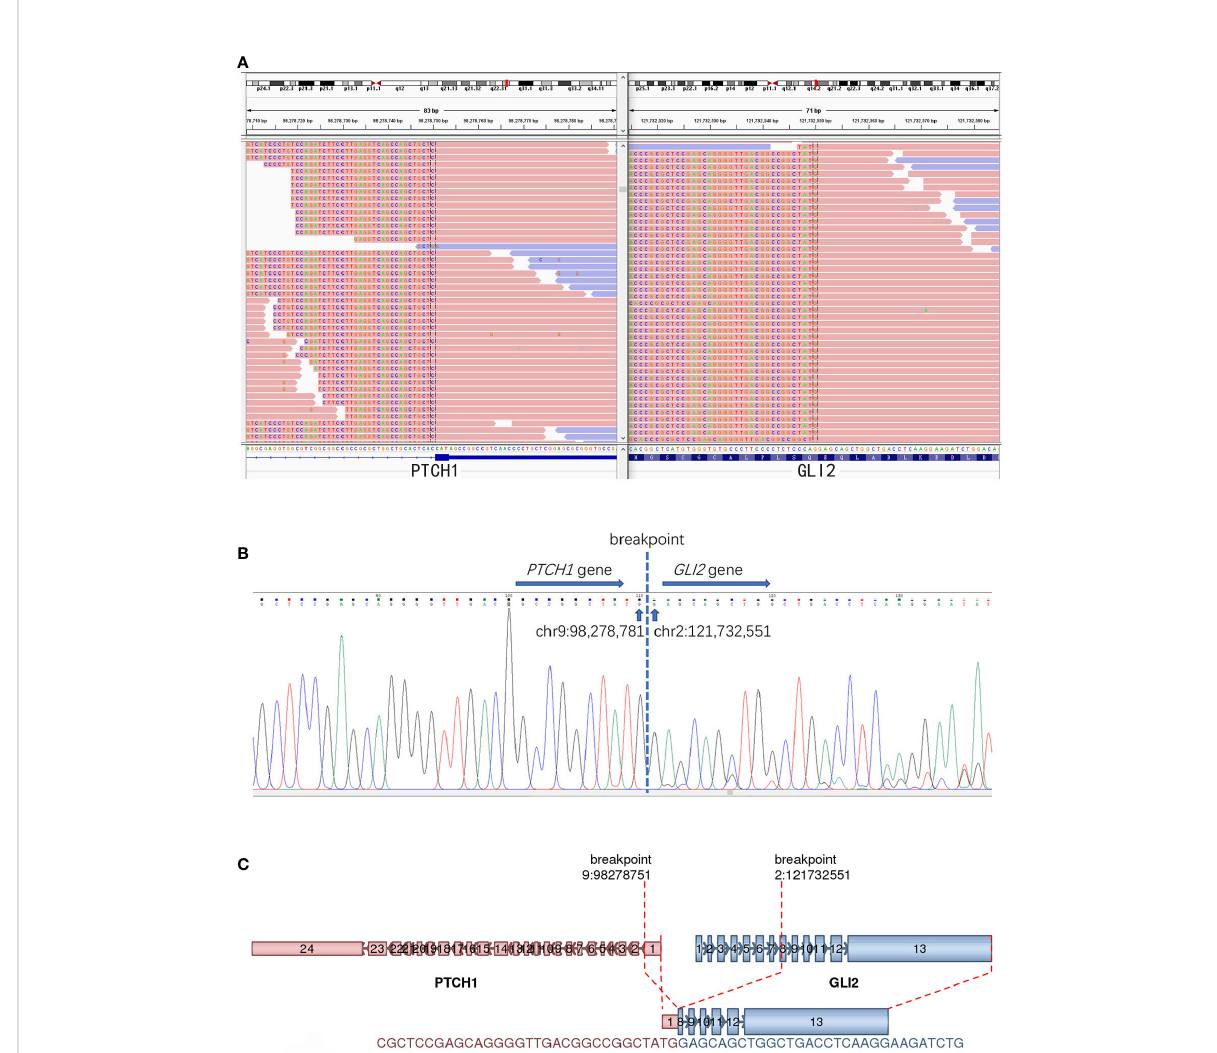
FIGURE 3 The detection of PTCH1::GLI2 fusion. (A) RNA-based NGS revealed a novel PTCH1::GLI2 fusion. (B) PTCH1::GLI2 fusion were con fi rmed by Sanger sequencing. (C) Schematic representation indicates PTCH1 (exon 1) ::GLI2(exon 8) fusion. Arrows indicate the direction of transcription for each gene. Exons and introns are represented by colored boxes and lines,